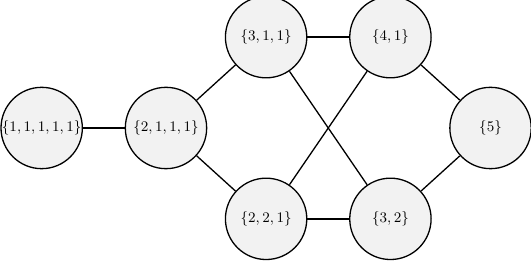
Figure 20: The network in model 3 when the total winding number is N =